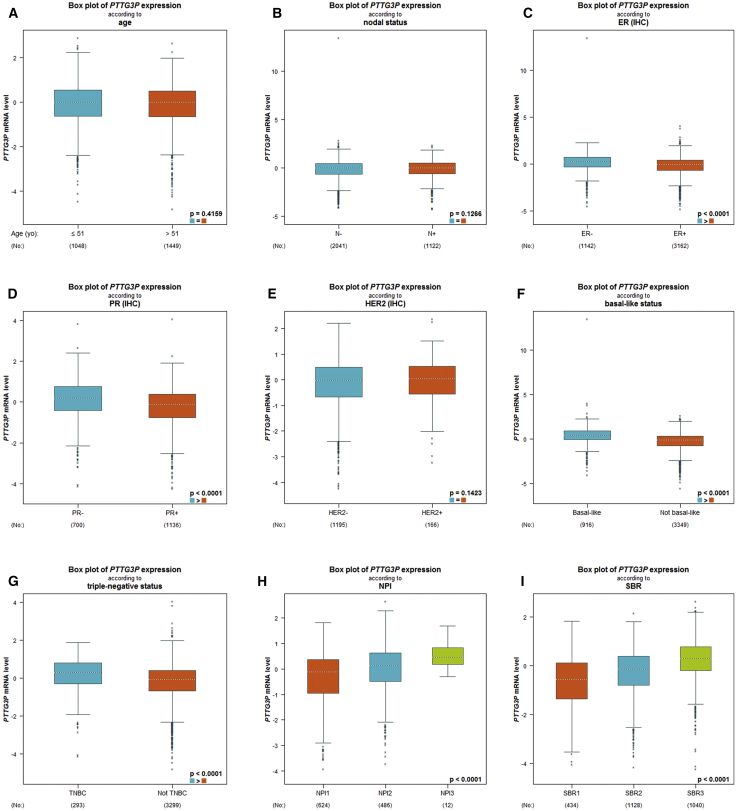
Relationship between Expression of PTTG3P and Various Clinicopathological Parameters of Breast Cancer Determined by the bc-GenExMiner Database(A) Boxplot of PTTG3P expression according to age; (B) boxplot of PTTG3P expression according to nodal status; (C) boxplot of PTTG3P expression according to ER; (D) boxplot of PTTG3P expression according to PR; (E) boxplot of PTTG3P expression according to HER2; (F) boxplot of PTTG3P expression according to basal-like status; (G) boxplot of PTTG3P expression according to triple-negative status; (H) boxplot of PTTG3P expression according to NPI; and (I) boxplot of PTTG3P expression according to SBR.